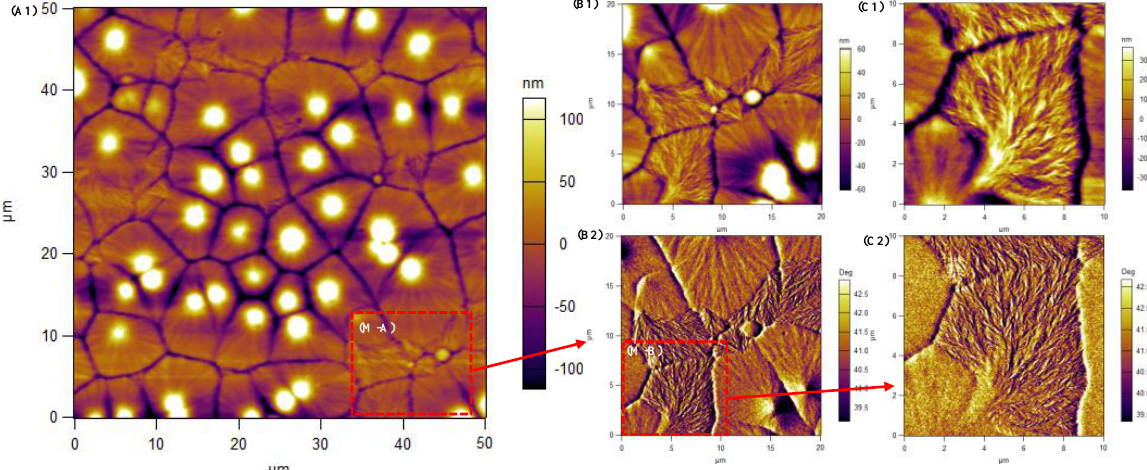
Figure 3. AFM height and phase images of center region of dried PVDF/DMF solution L-droplet. ( 1 ) height image, ( 2 ) phase image, ( A ) 50 μm × 50 μm, ( B ) 20 μm × 20 μm, ( C ) 10 μm × 10 μm, (M-A) magnified region of A, (M-B) magnified region of B.